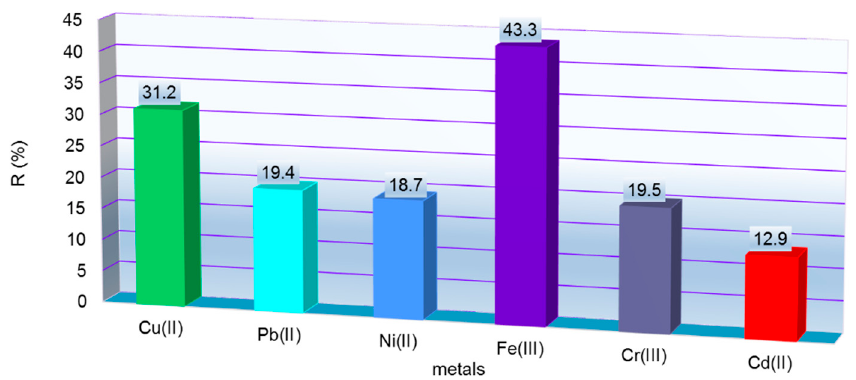
Figure 6. Removal of M X+ from tannery wastewaters onto MS mass. Experimental conditions: 0.04 L of tannery wastewaters that contained M X+ (Ci = 0.218 mg Cu 2+ /L, 0.618 mg Pb 2+ /L, 1.073 mg Ni 2+ /L, 0.163 mg Cd 2+ /L, 1006 mg Cr 3+ /L and 0.633 mg Fe 3+ /L), contact time 60 min, 175 rpm, 0.5 g MS, pH = 4.3.